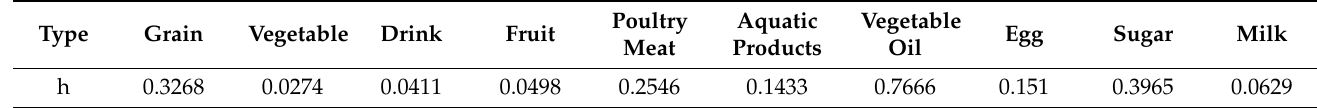
Table 1. Carbon emission coefficient of food consumption (unit: ton